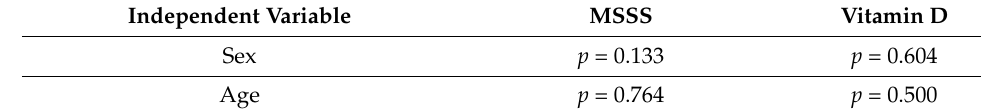
Table 3. Univariate analysis to predict MSSS and vitamin D levels. Independent Variable MSSS Vitamin D Sex p = 0.133 p = 0.604 Age p = 0.764 p = 0.500 p = 0.002 * p = RRMS 2.44 Form of the disease (RRMS vs. all others) Others 6.47